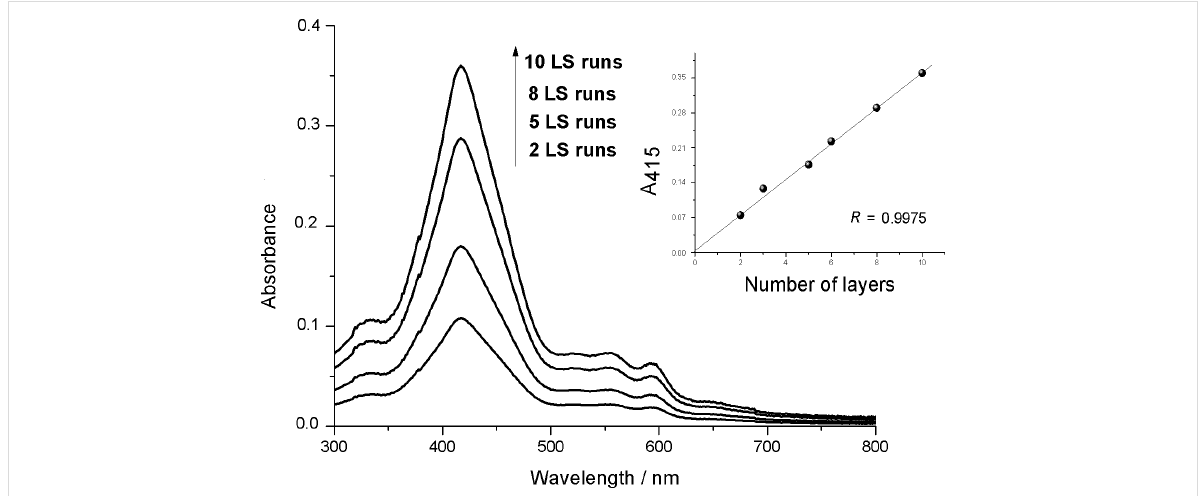
Figure 6: UV–vis spectra in the range of 300–800 nm of the Cu,H 2 -Por 2 Langmuir–Schaefer films. The linear dependence of the absorbance on the LS layer number is highlighted in the inset.